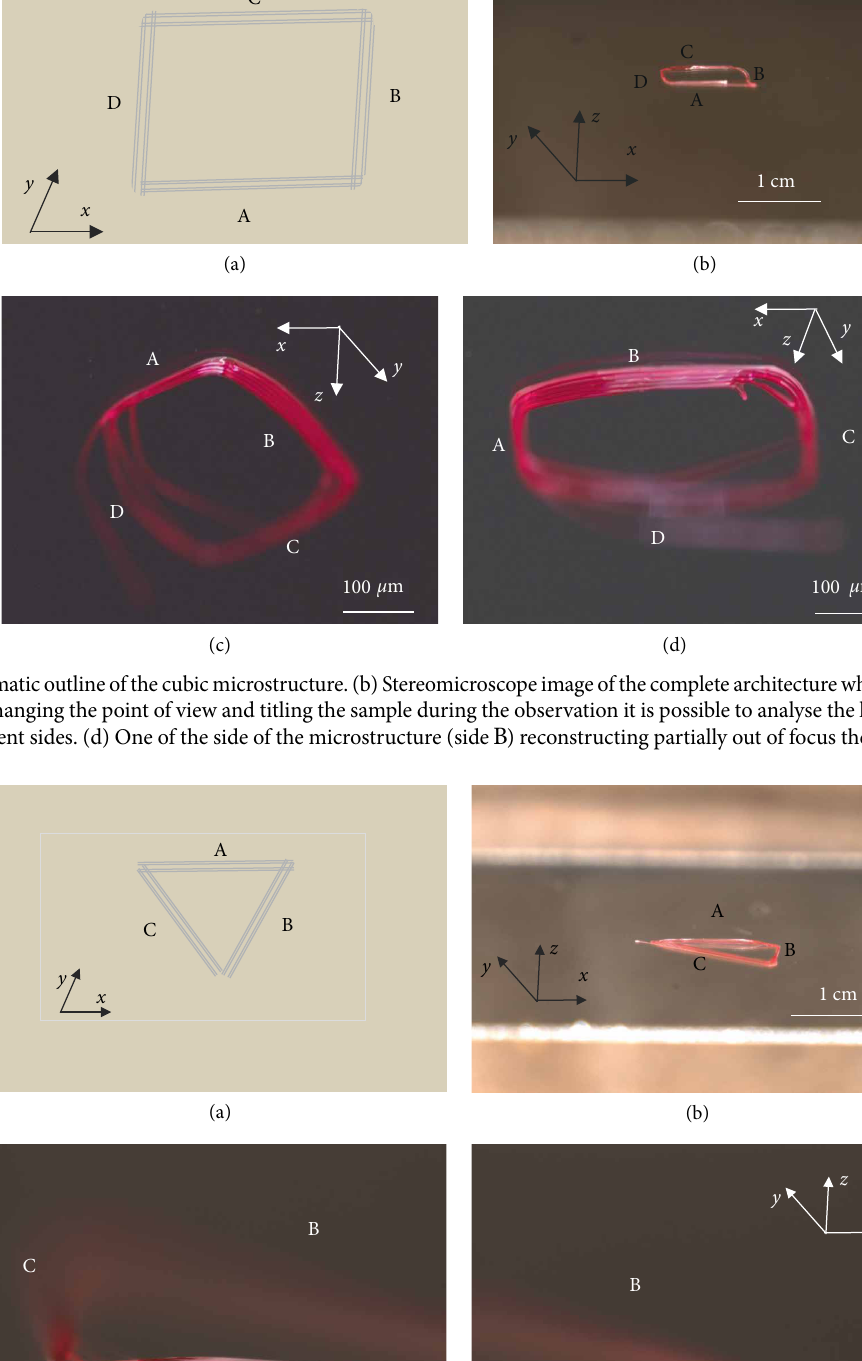
Figure 7: (a) Schematic outline of the triangular microstructure. (b) Stereomicroscope image of the complete architecture where every side C A B , , ). (c) Changing the point of view and titling the sample during the observation it is possible to analyse the multi-layered was named ( A ) reconstructing partially out of focus the remaining profile and the other side profile. (d) One of the side of the microstructure (side